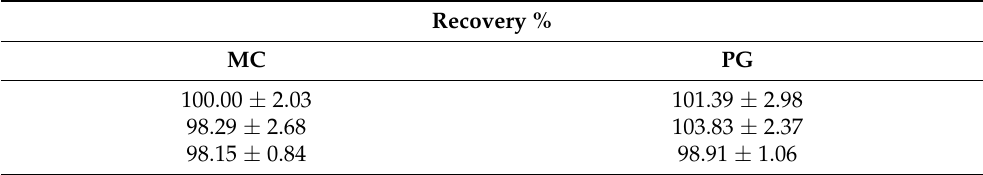
Table 3. PG and MC recovery % data after 72 h ( Ⴟ ± SD).